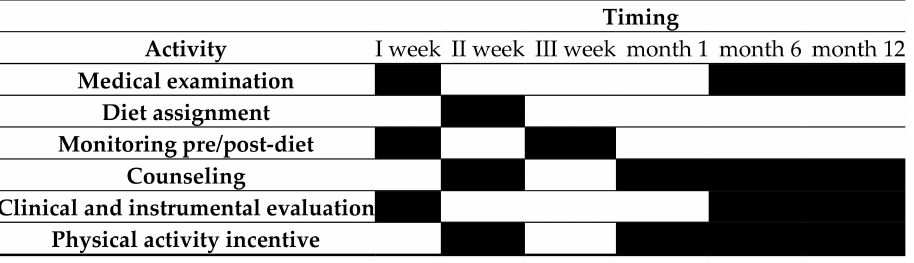
Figure 1. Gantt chart of procedures from time zero (T0) to after 12 months